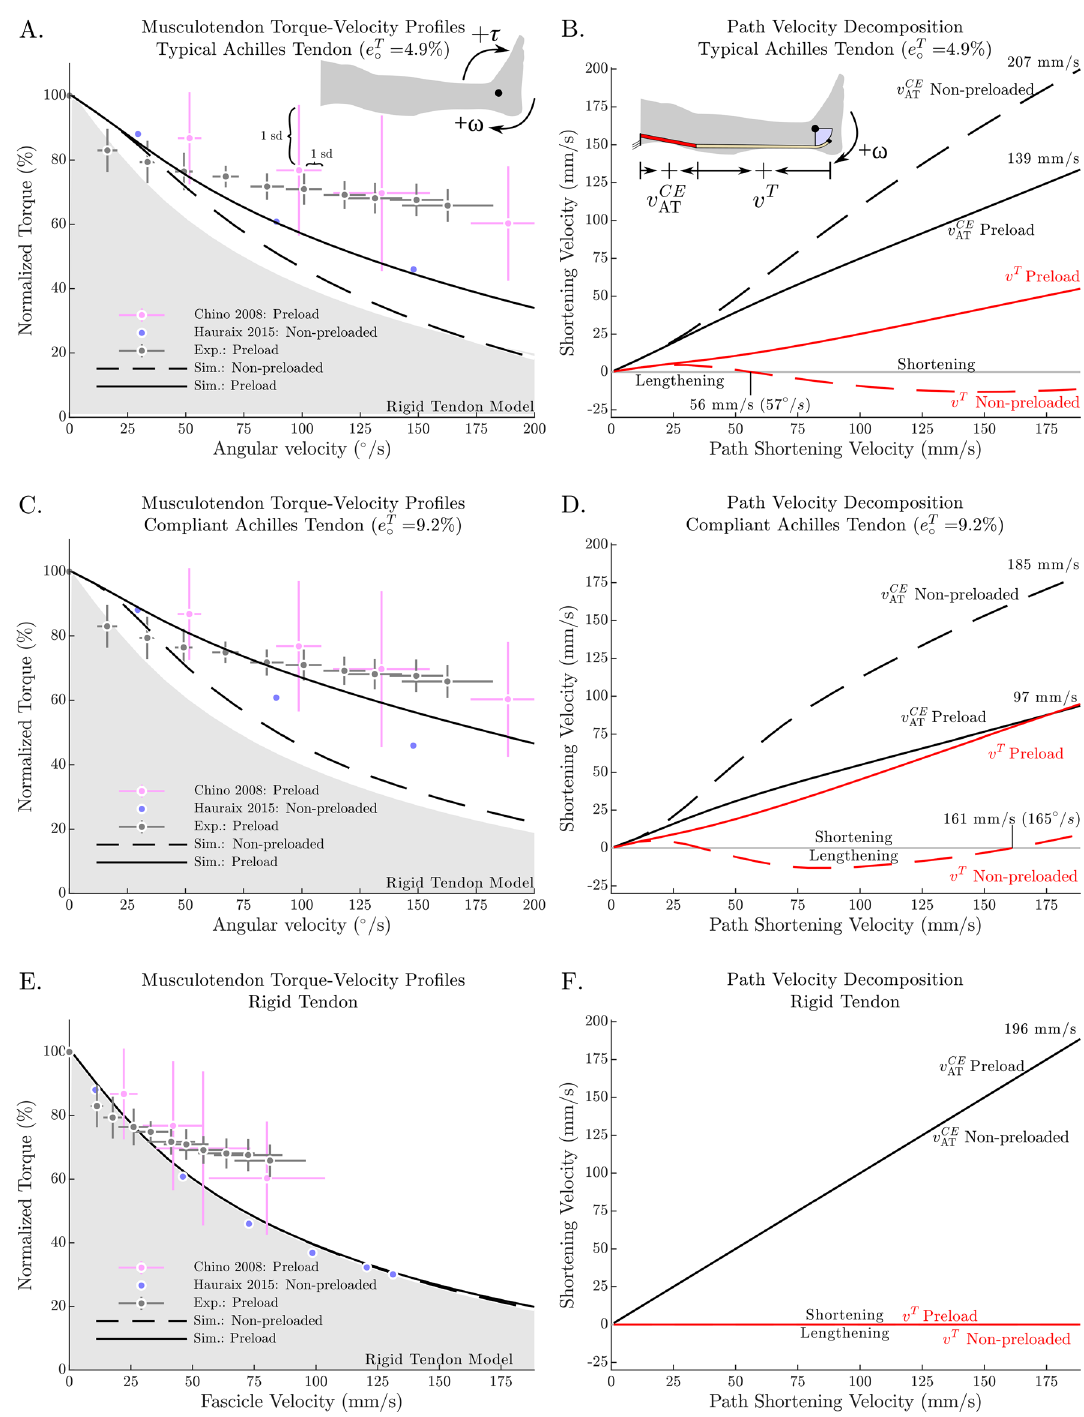
Figure 3. The T–ω–r relationship is influenced by both the amount of preload prior to shortening and the elasticity of the tendon. In the simulation, as the ankle angular velocity increases, a preloaded muscle-tendon unit (MTU) is able to develop larger torques than a non-preloaded MTU ( A ). A similar pattern was found in the experimental data (n = 11), where preloaded protocols (our data and Chino et al. 26 ) led to larger torques with increasing angular velocities compared with non-preloaded protocols 27 as ankle angular velocity increases ( A ). Our simulation results point to the reason for this difference between the two protocols: during a preloaded protocol, the contractile element (CE) shortens more slowly because both, the CE and the tendon shorten together ( B ); in contrast, during a non-preloaded protocol the CE shortens at a higher velocity since the tendon can lengthen when CE force increases. As a result, the force–velocity properties of muscle limit the force of the non-preloaded CE to smaller forces and thus, smaller torques. In the simulation, we found that the difference between the two protocols is more pronounced with a compliant tendon (compare C to A , and D to B ). In contrast, if a rigid tendon model is used (illustrated as the filled grey area in A , C , and E ), there is no difference between the preloaded and non-preloaded protocols (see E , F ). All torques have been normalized to the maximum torque during a fixed-end contraction at an ankle angle of